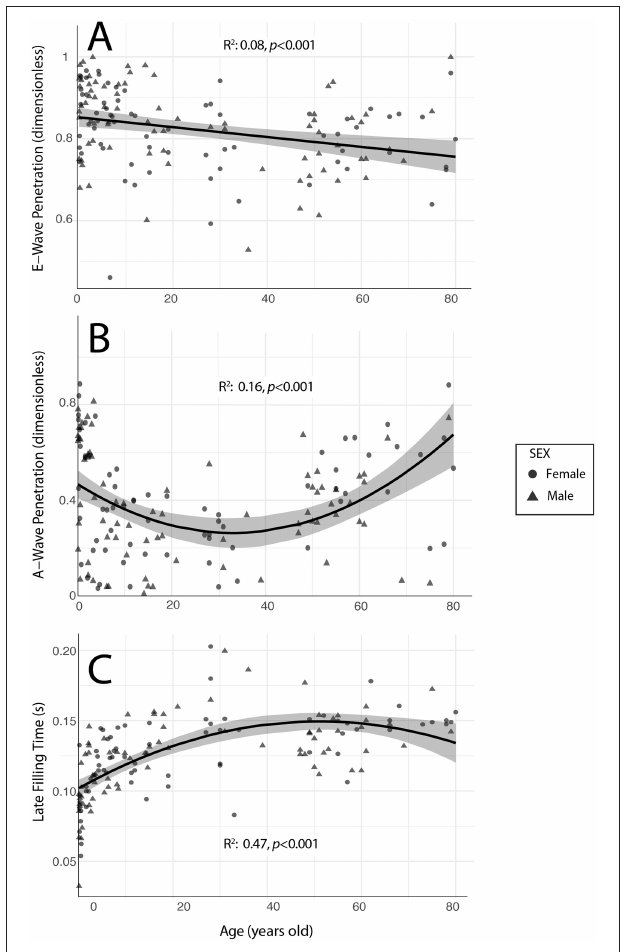
FIGURE 4 | Relationship between age and the diastolic properties related to ( RT ): E-wave penetration (A) , A-wave penetration (B) and Late Filling time (C) . Symbols account for